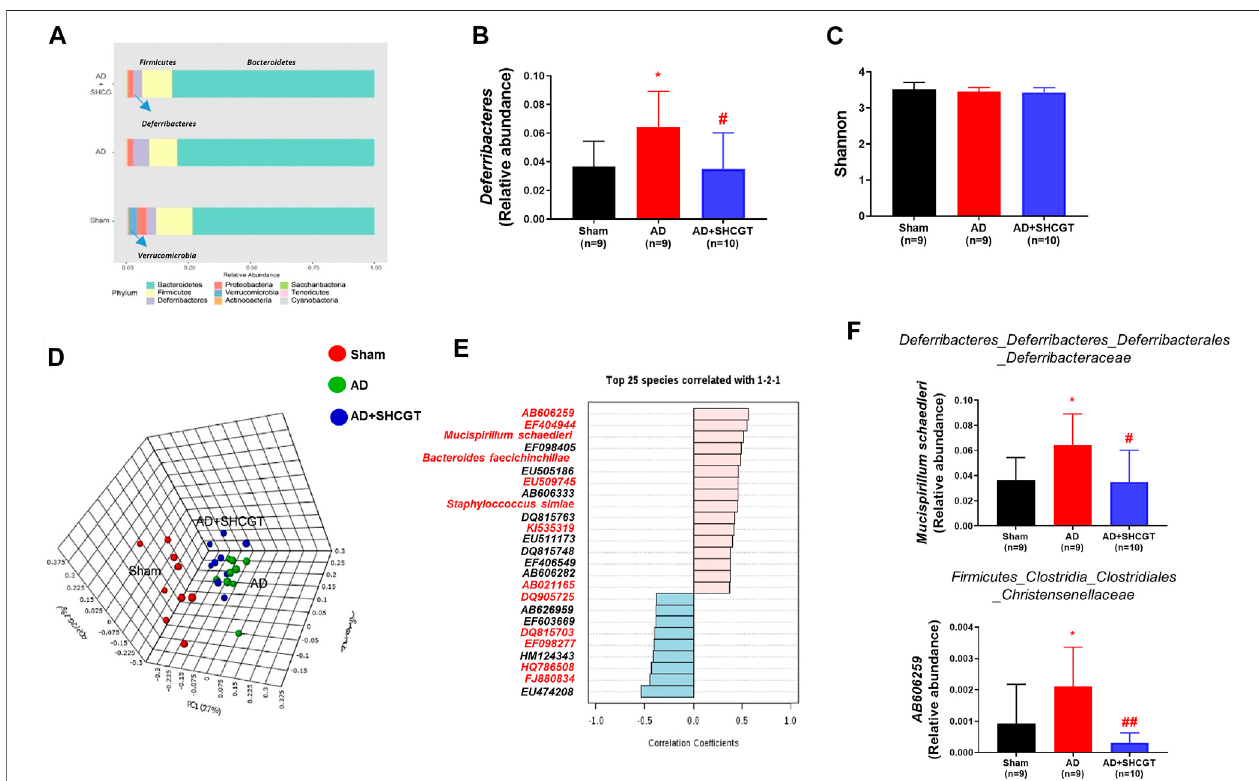
FIGURE5| SHCGTchangedthegutmicrobiomeinmicewithDNCB-induced AD. (A) Taxonomic compositionofthemicrobialcommunityinthegutatthephylum level. (B) The increased relative abundance of Deferribacteres was attenuated by SHCGT in mice with AD. (C) Alpha diversity using the Shannon index score at the species level. No signi fi cant differences were observed. (D) A three-dimensional score plot based on principal coordinates analysis of weighted UniFrac distances showing different microbiome patterns in each group. (E) Top 25 species detected in pattern search analysis. The red letters indicate the gut microbiota components also detected by LEfSe analysis. (F) A signi fi cantly altered gut microbiota pro fi le was identi fi ed by a combination of pattern search analysis, LEfSe, and univariate analysis. * p < 0.05 vs. sham; # p < 0.05, ## p < 0.01 vs. AD. AD, atopic dermatitis; DNCB, 2,4-dinitrochlorobenzene; LEfSe, linear discriminant analysis effect size; SHCGT, Sihocheonggan-Tang